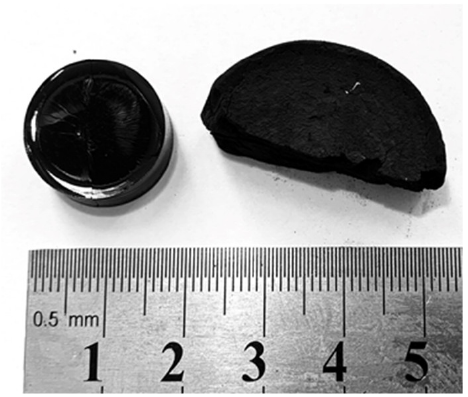
Figure 2. ( Left ) A non-porous dry organic xerogel upon collapse of nanoporosity (significant drying shrinkage) and ( right ) corresponding macroporous xerogel (obtained with the addition of isopropanol as an antisolvent), which did not undergo collapse of porosity and shrinkage during